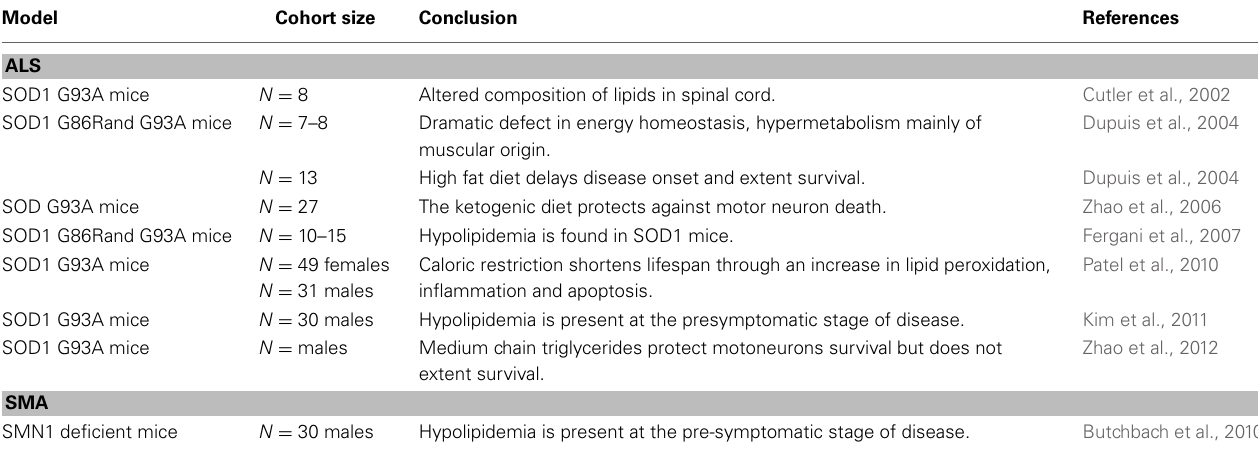
Table 2 | Altered energetic metabolism in mouse models of